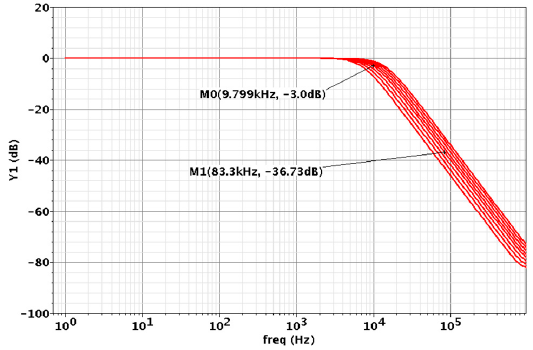
Figure 9. Frequency response simulation results of the low pass filter (LPF).